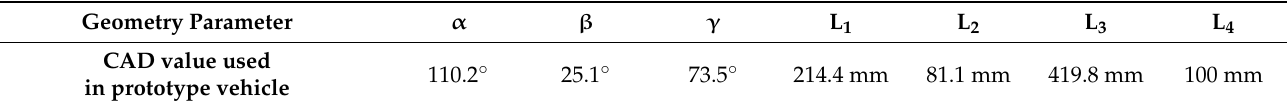
Table 1. Geometry parameters used in experiments with the prototype vehicle. Definitions of the geometry parameters are shown in Figure 3. Alternative geometry setups, as well as a visualization of the geometry setup are presented in Section